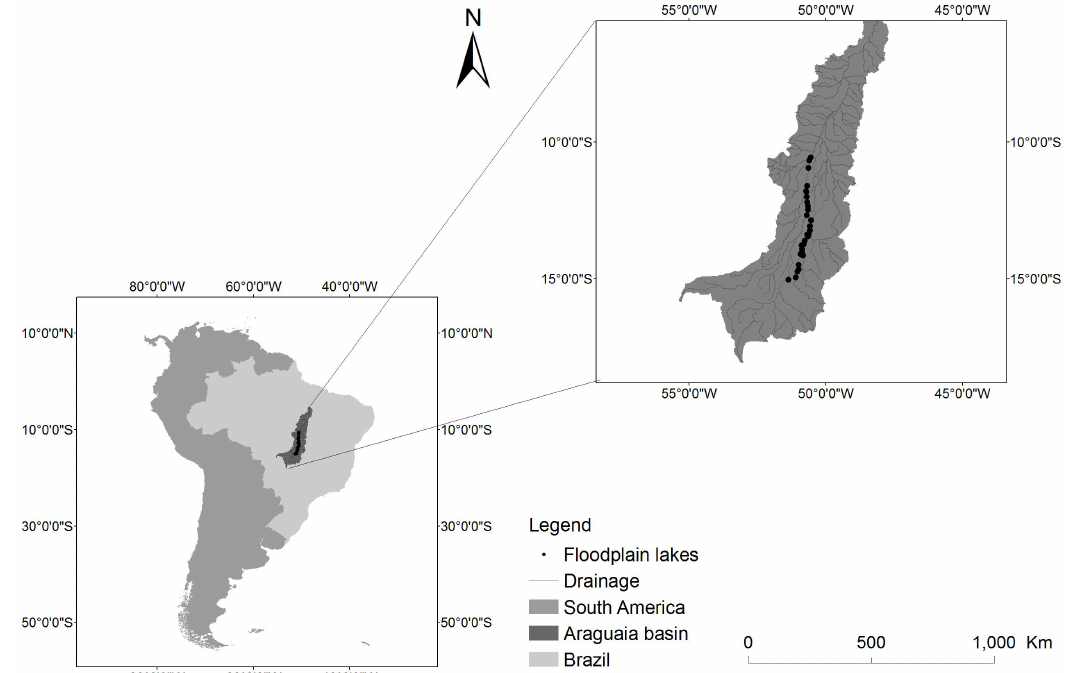
Figure 1. Location of the Tocantins-Araguaia river basin, highlighting the sampling points used in this